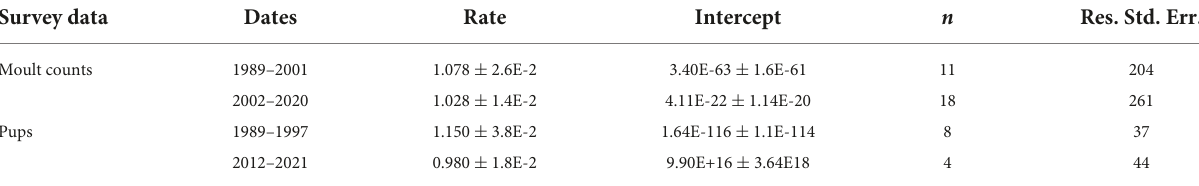
TABLE 5 Exponential growth models were used to estimate the realised growth rates for moult and pup counts for the time periods before (1989–2001) and after (2002–2021) the most recent Phocine Distemper Virus (PDV) outbreaks. Survey data